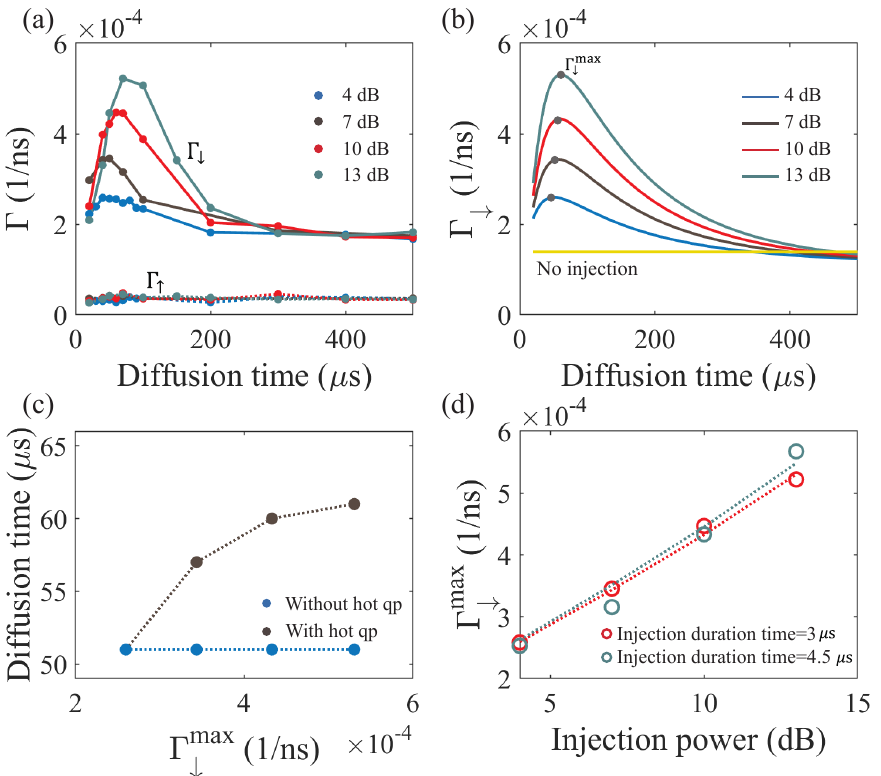
Figure 3. Quasiparticle diffusion in the superconducting qubit. ( a ) Transition rate as a function of diffusion time. The solid circles on the dotted (solid) line represent the up- and down-transition rates Γ Γ r ↑ ( ↓ ) extracted from T 1 and P e . The four colored curves point to the four injection powers. These data were measured with an injection duration of 3 µ s. ( b ) Γ ↓ as a function of diffusion time fitted by the modified model with different injection powers. ( c ) The diffusion time corresponding to the fitted Γ max ↓ with (without) the existence of “hot” quasiparticles. ( d ) Γ max ↓ corresponding to different injection powers when measured with injection durations of 3 and 4.5 µ s. The experimental data and simulated results are represented by circles and dotted lines,